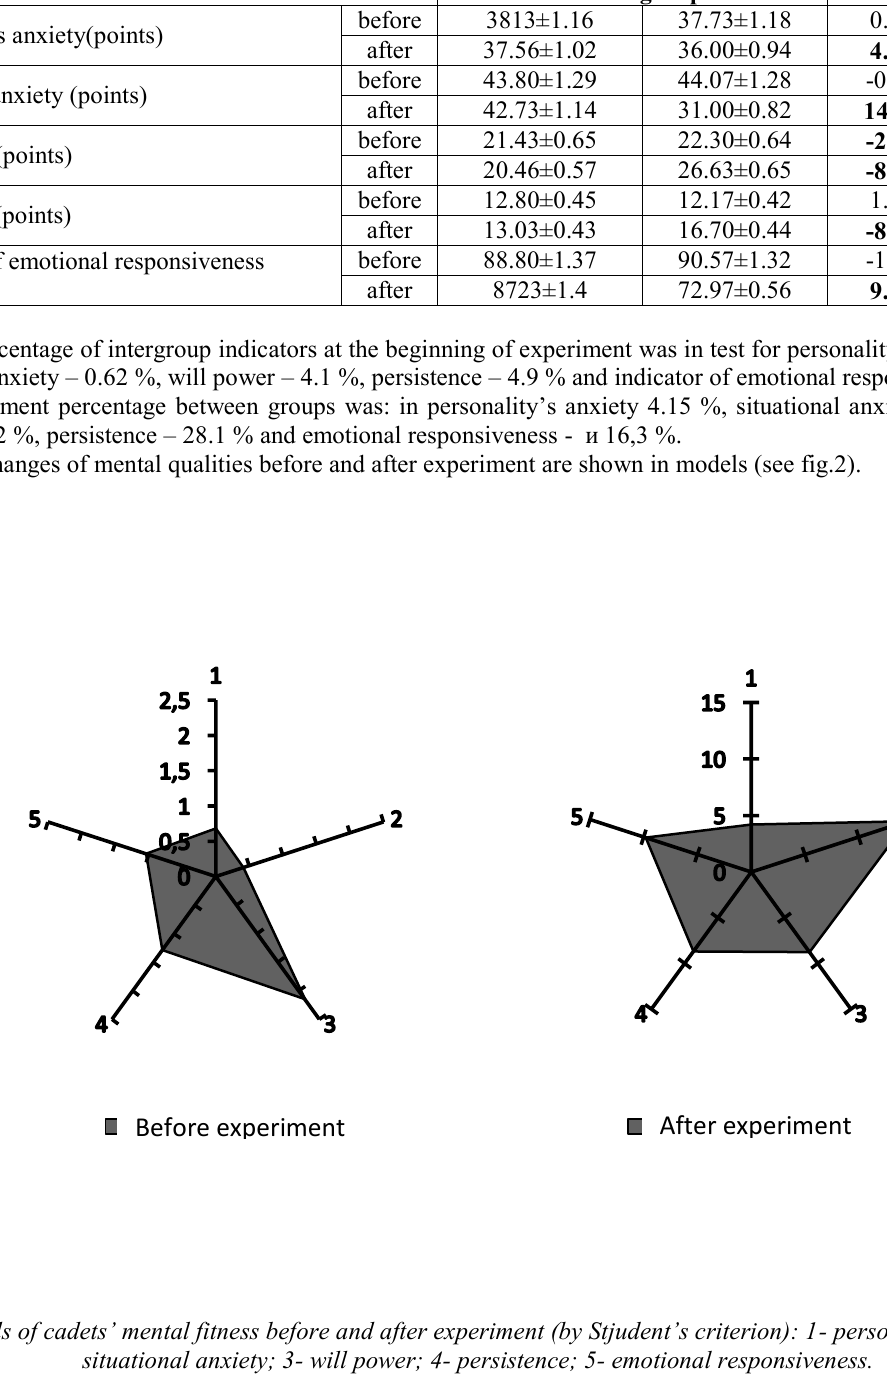
Fig.2 Models of cadets’ mental fitness before and after experiment (by Stjudent’s criterion): 1- personality’s anxiety; 2- situational anxiety; 3- will power; 4- persistence; 5- emotional responsiveness.